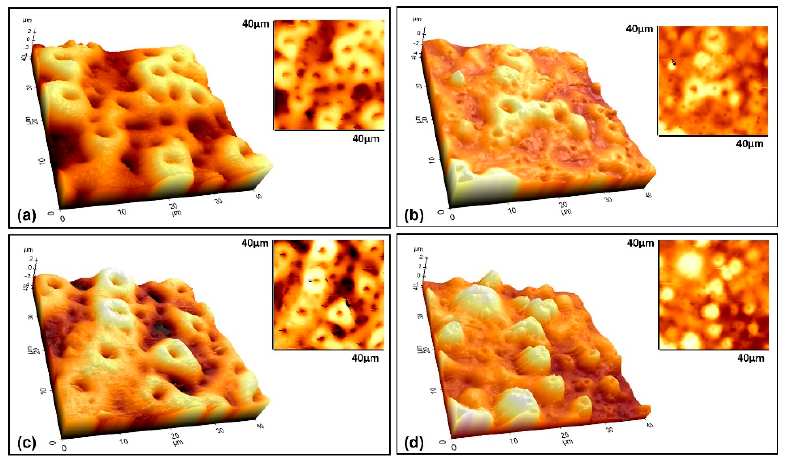
Figure 7. 3D AFM topographic and wide–area (40 × 40 µ m) surface images of the coatings reinforced with ( a ) free – GNS (only nHA), ( b ) 0.5, ( c ) 1.0, and ( d ) 1.5 GNS.